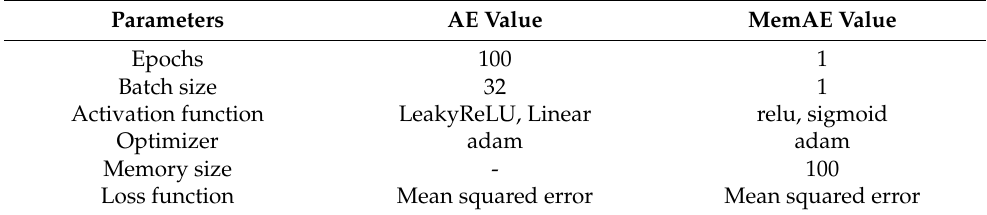
Table 4. Parameters used in the